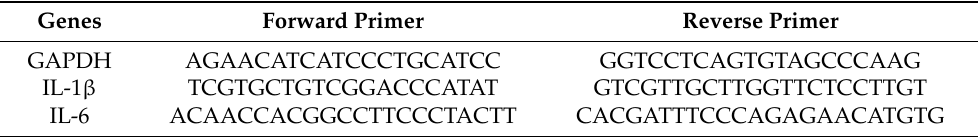
Table 3. Sequence of qPCR